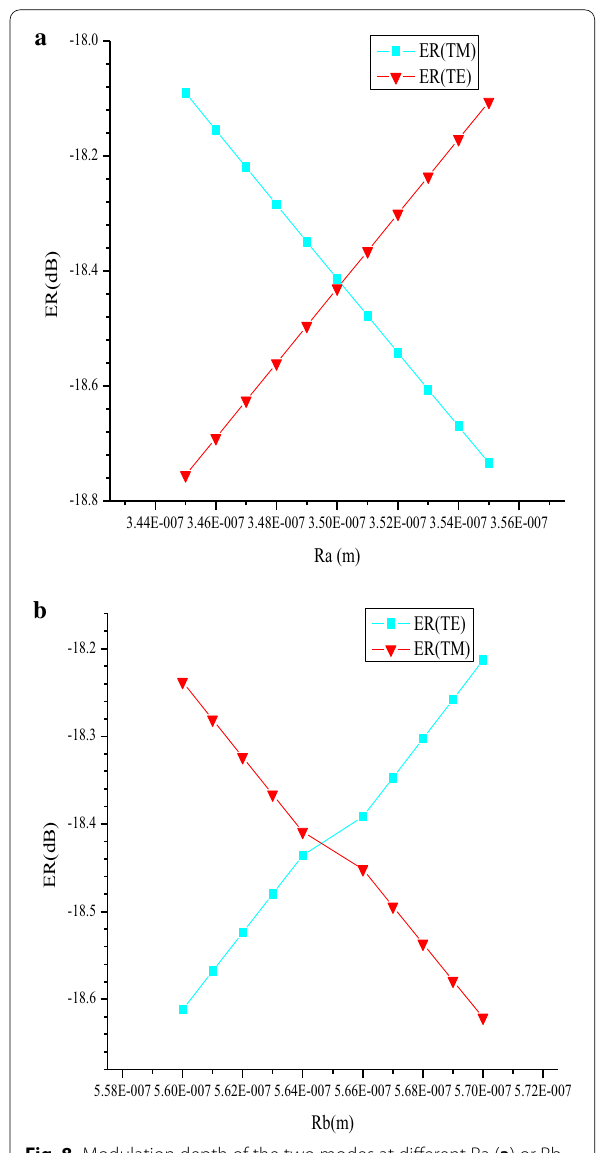
Fig. 8 Modulation depth of the two modes at different Ra ( a ) or Rb ( b